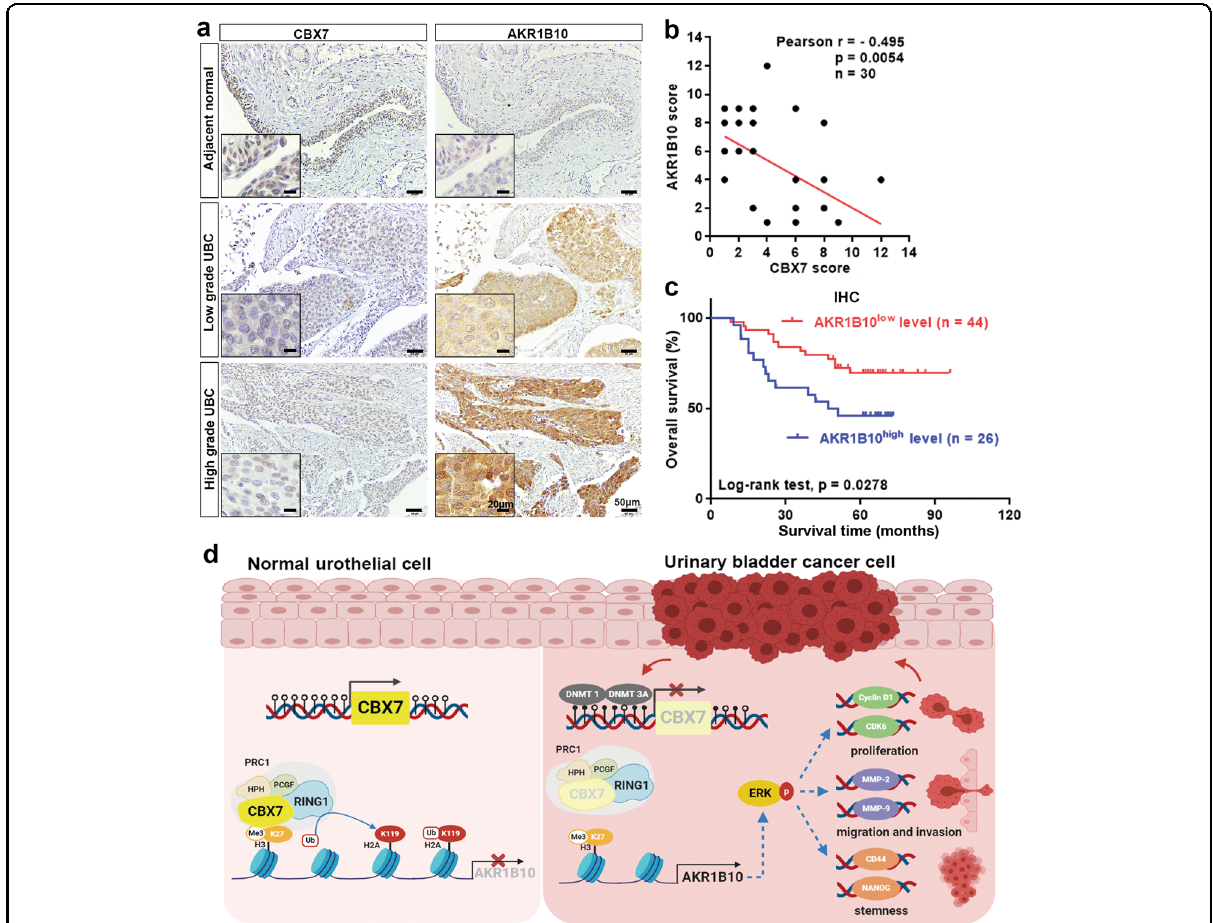
Fig. 8 The dysregulation of CBX7 – AKR1B10 axis is associated with poor clinical outcome. a Representative IHC staining images of the localization and expression level of CBX7 and AKR1B10 in adjacent normal tissues and UBC tissues were displayed. Scale bar, 50 μ m; inset, 20 μ m. b Pearson correlation analysis showed a signi fi cant negative correlation between CBX7 and AKR1B10 expression. c Kaplan – Meier survival plot for AKR1B10 was constructed according to the IHC staining score. d A working model of CBX7/AKR1B10/ERK axis in UBC